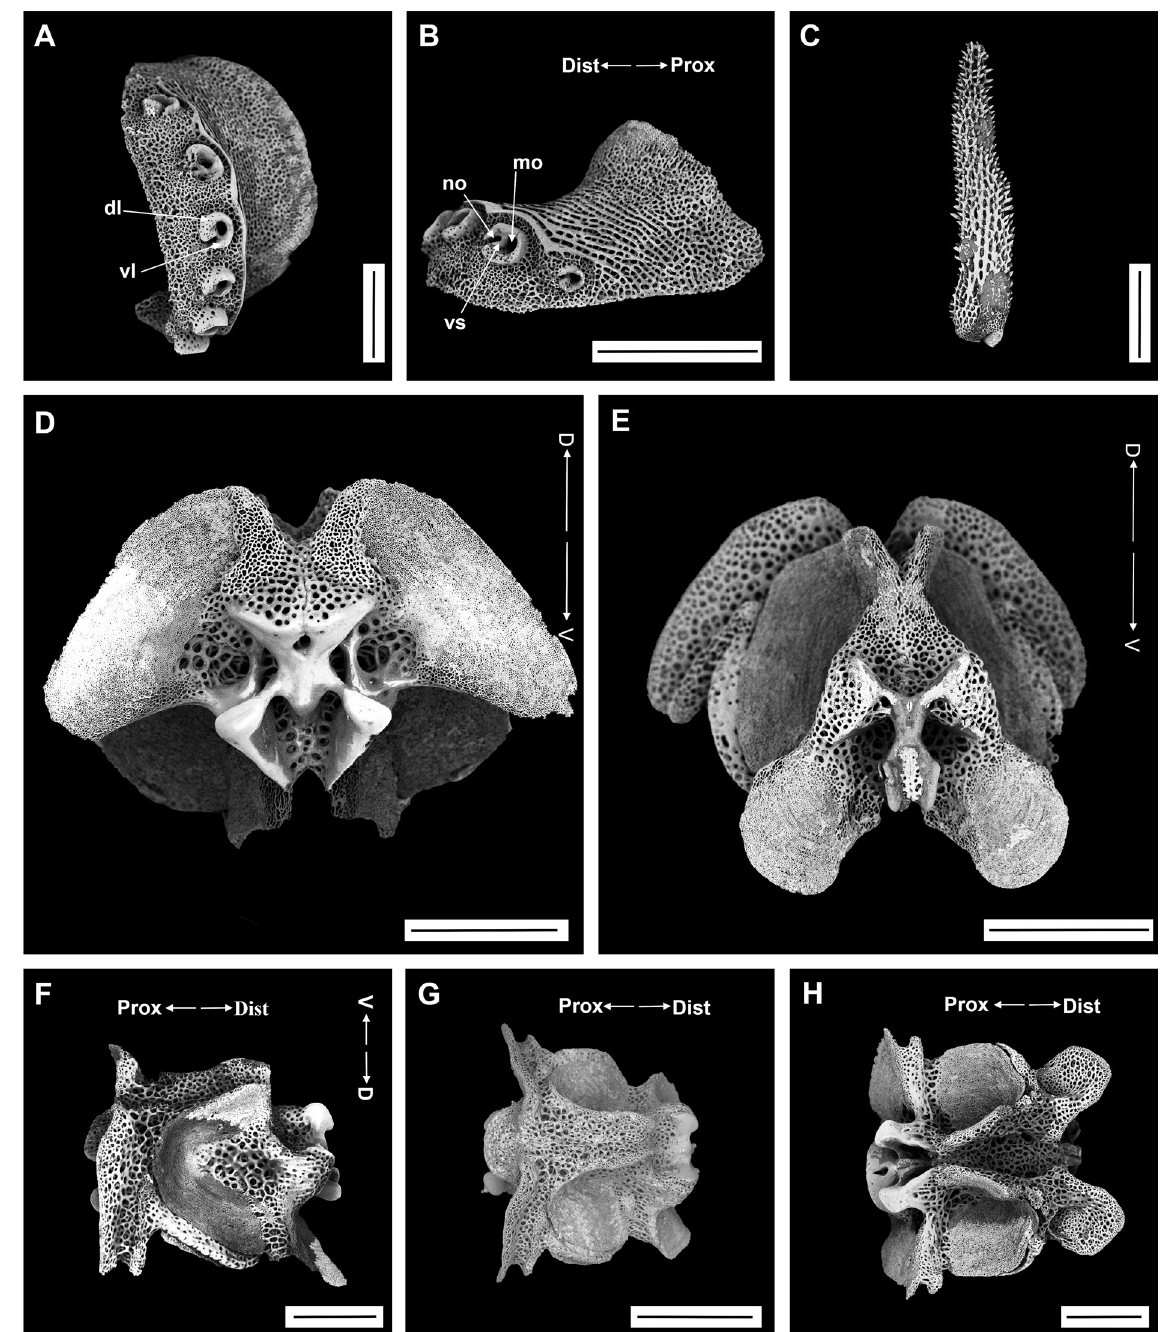
Fig. 30. Ophiacantha vorax Koehler, 1897, SEM (IDSSE EEB-SW0011). A–B . Lateral arm plate. C . Ventral arm spine. D–H . Vertebrae. D . Proximal view. E . Distal view. F . Lateral view. G . Dorsal view. H . Ventral view. Abbreviations: D = dorsal; Dist = distal; dl = dorsal lobe; mo = muscle opening; no = nerve opening; Prox = proximal; V = ventral; vl = ventral lobe; vs = volute-shaped. Scale bars: A, C–F, H = 300 µm; B, G = 500